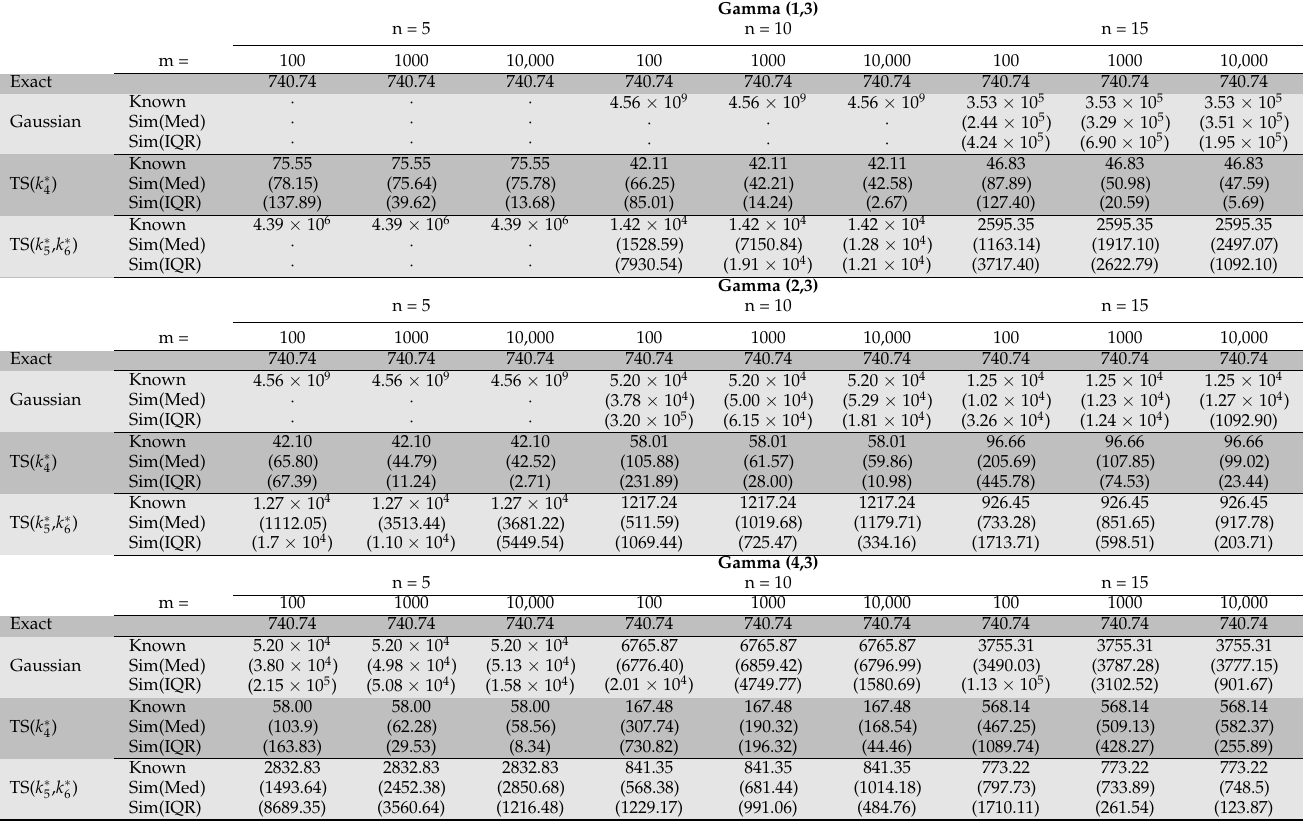
Table 3. In-control ARLs for the LCL of an ¯ X -chart on a Gamma ( γ ,1/ λ ) distributed